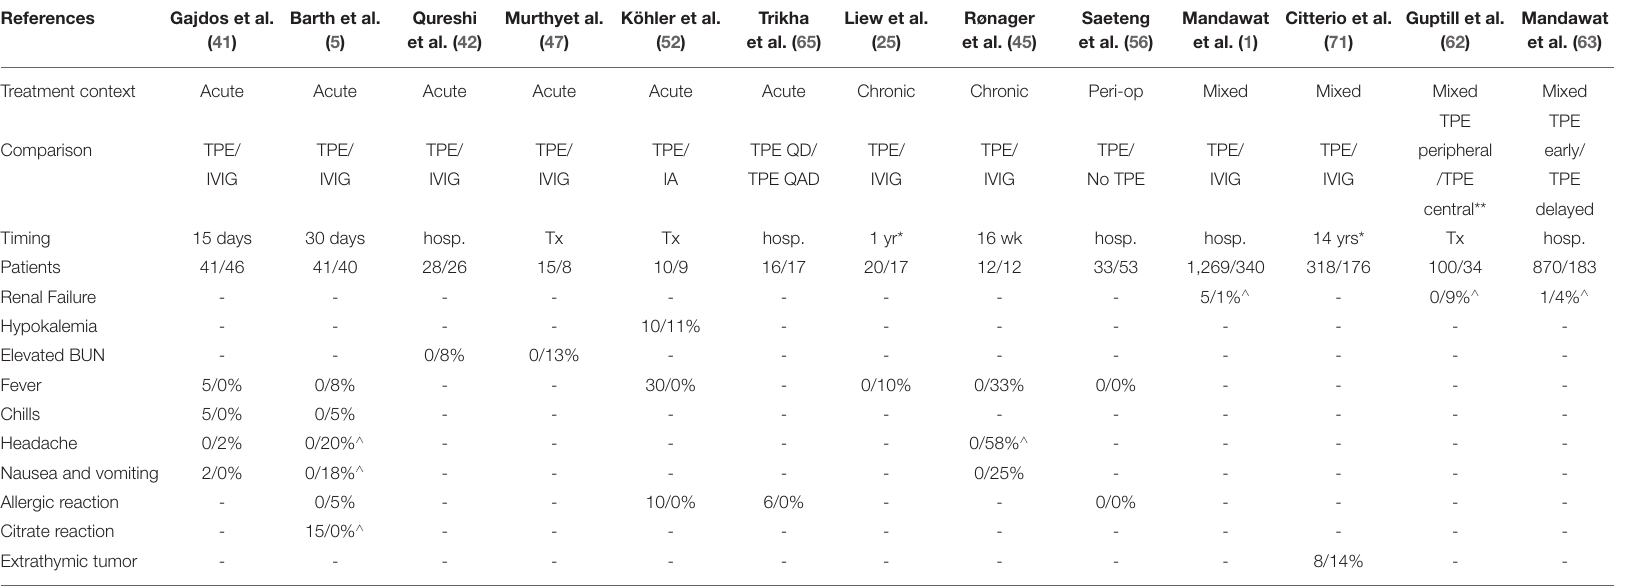
TABLE 11 | Additional comparative adverse event data for TPE in MG.